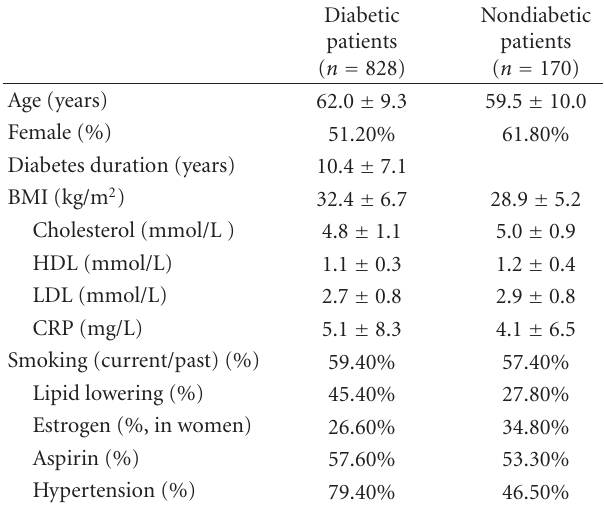
Table 1: Clinical and laboratory characteristics of Caucasian DHS